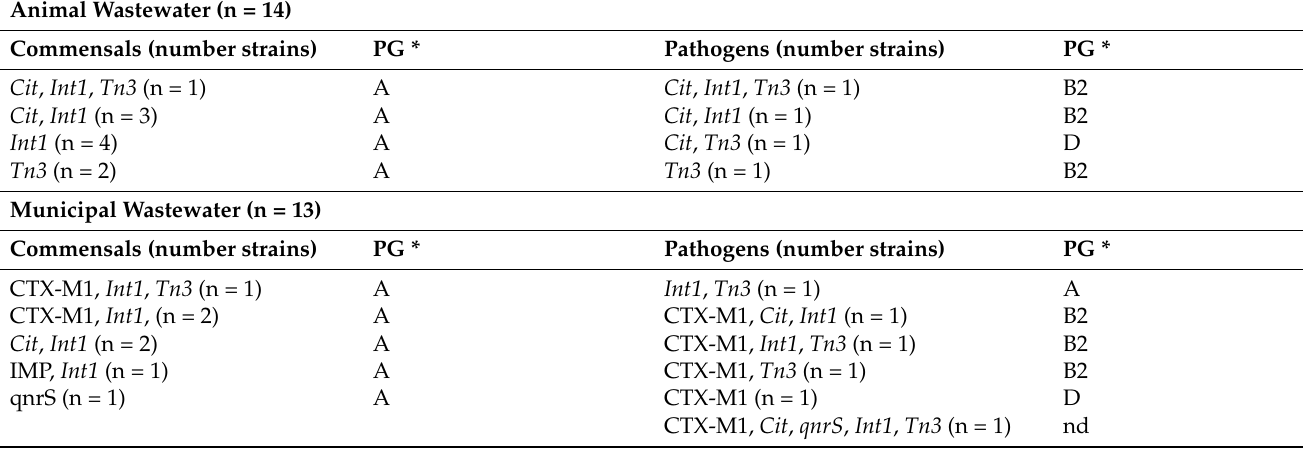
Table 1. Resistance genotyping of 14 strains of E. coli from the animal wastewater and 13 from the municipal wastewater. Animal Wastewater (n =